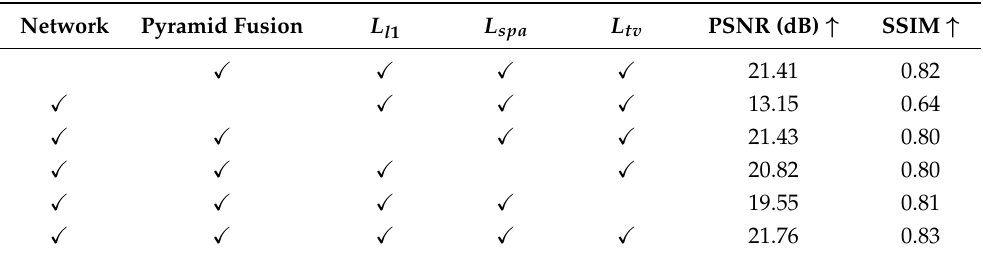
Figure 7. Subjective results of ablation studies on different modules. Comparing the recovered tones and brightness, the enhanced outcome obtained by LIMPID is closer to the ground truth overall. Table 3. PSNR and SSIM metrics obtained in the ablation study. The values of both metrics acquired when integrating all components are